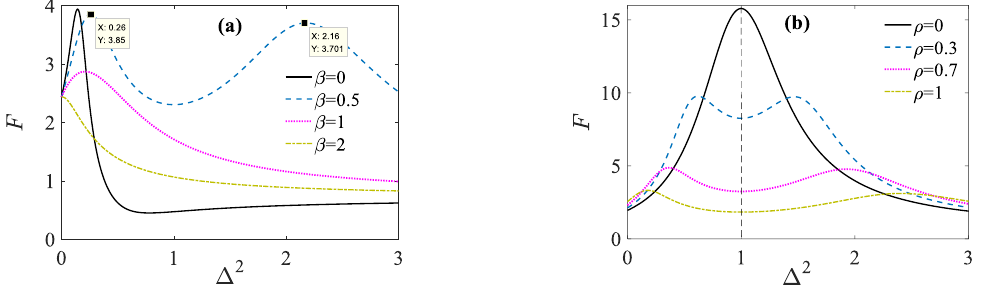
Figure 10. Influence of the variation in noise intensity on the output steady-state amplitude of system (16) under different nonlinear noise coefficient and delay intensity ( a ) ρ = 0.8, ( b ) β = 0.5. Under low noise switching rate condition, examining the effect of damping order q